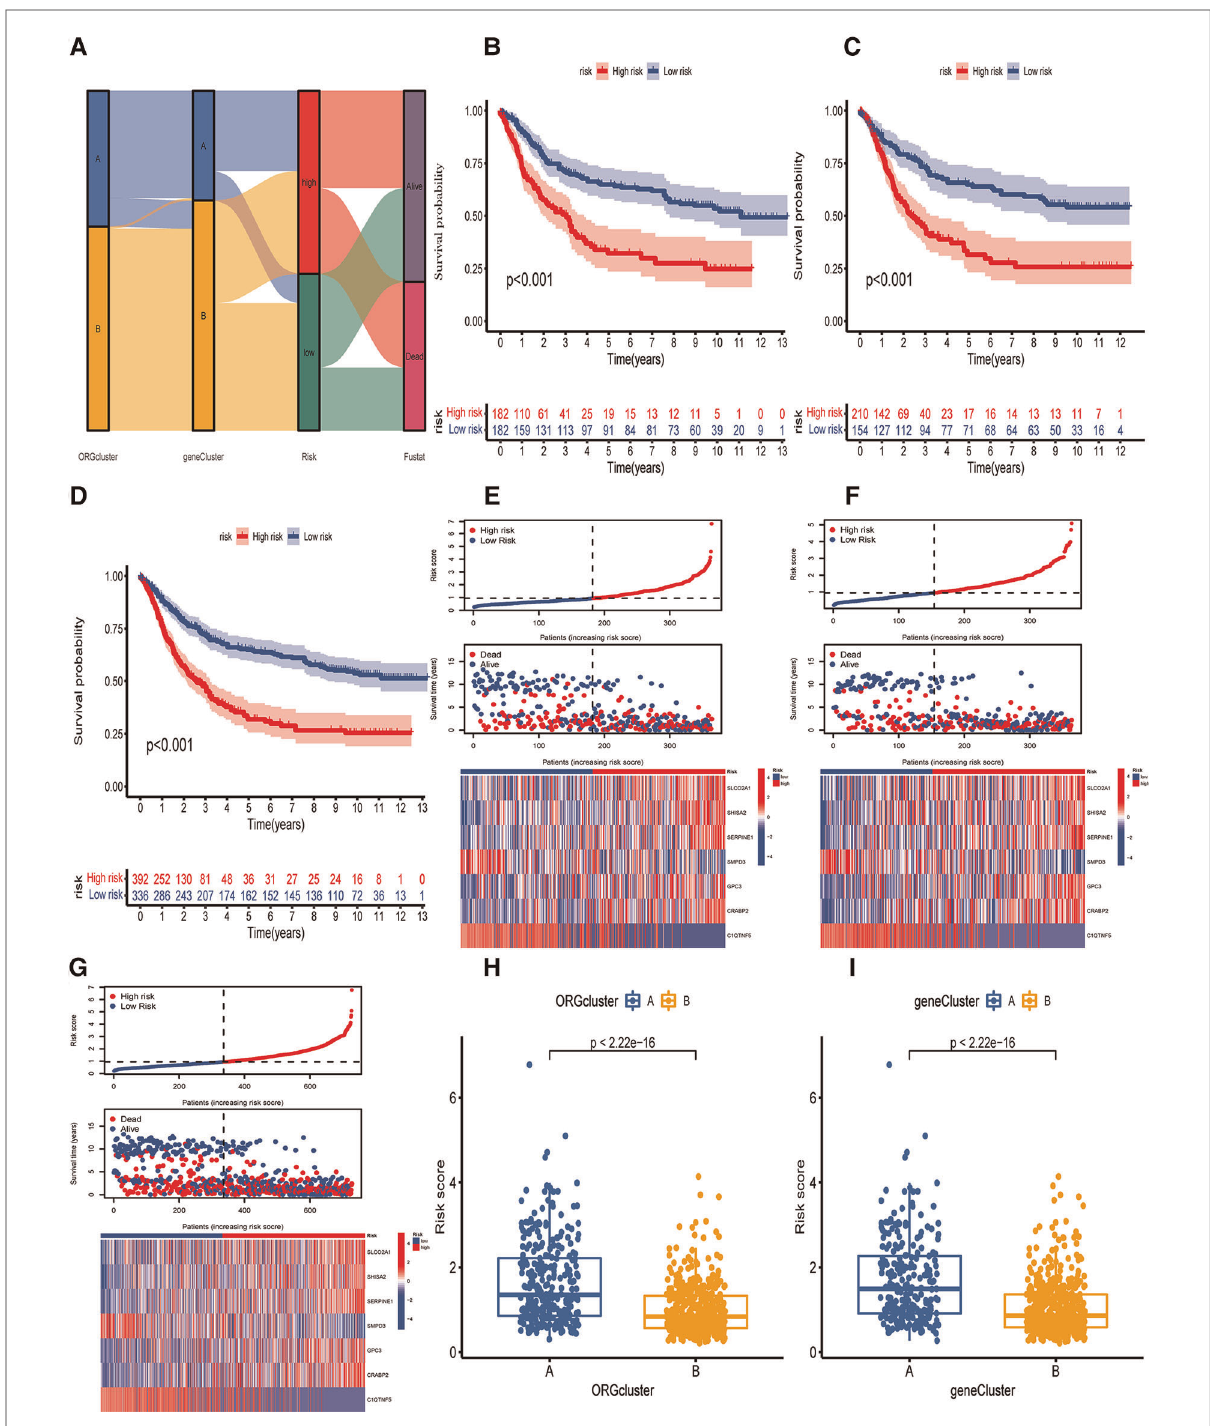
FIGURE 4 Survival analysis or OE_score in training set, test set and total data set. ( A ) Alluvial diagram of the distribution of the survival state of the samples of ORGcluster, genecluster and OE_score subgroups. ( B ) Survival differences between the two subgroups of the training group. ( C ) survival differences between the two subgroups of the test group. ( D ) Survival differences between the two subgroups of the total data set. ( E ) The risk score distribution and survival status in the training group, and the gene expression involved in the construction of OE_score. ( F ) The risk score distribution and survival status in the test, and the gene expression involved in the construction of OE_score. ( G ) The risk score distribution and survival status of the total data set, and participate in the construction of gene express of OE_score. ( H,I ) The difference of OE_score between ORGcluster and genecluster